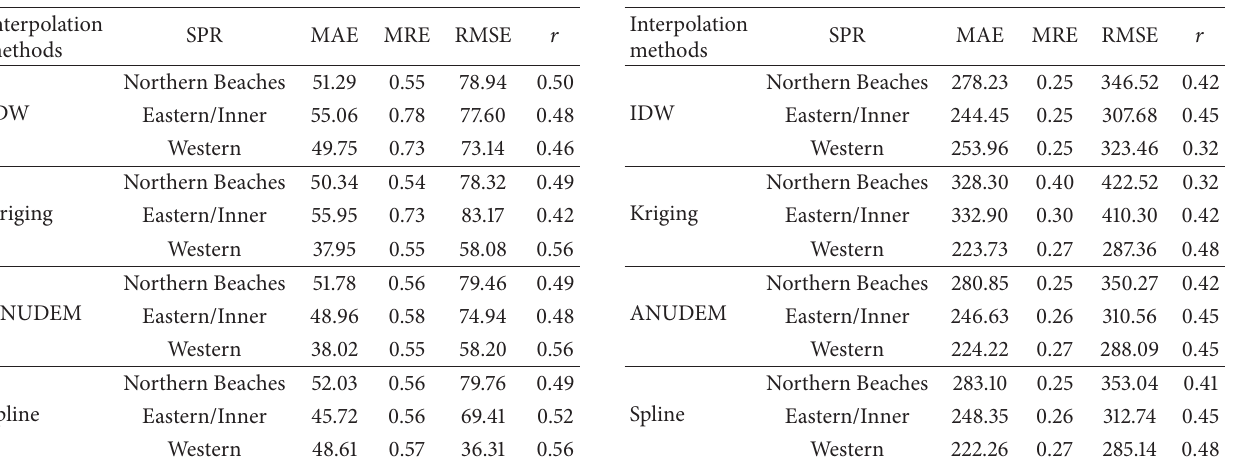
Table 4: Error assessment of interpolated annual rainfall in state plan